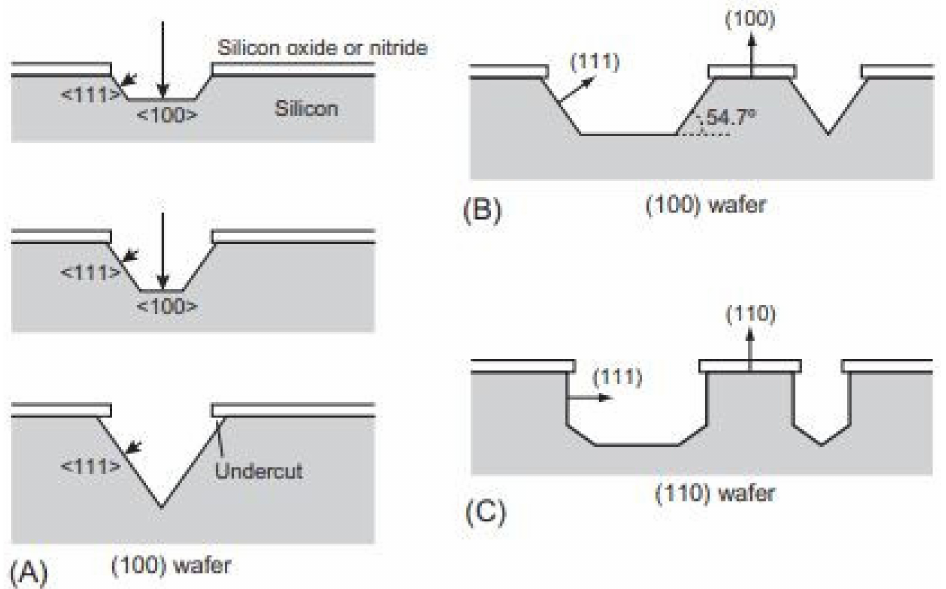
Figure 11. The anisotropic silicon wet etching (side view). ( A ) Etching in the <100> direction is much faster than in the <111>direction. ( B ) An angle of 54.7 ◦ is observed between (100) and (111) surfaces. ( C ) Vertical walls are created with (110) wafers [134]. (Reprinted with permission from Ref. [134]. Copyright 2014